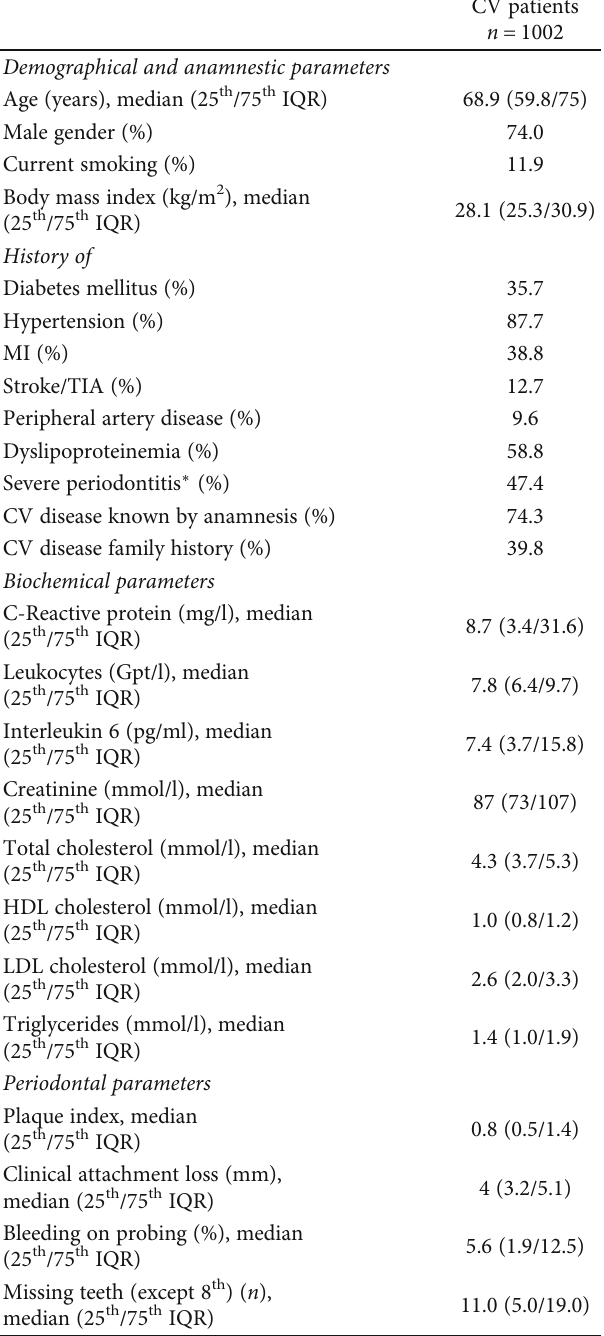
Table 2: Demographical and anamnestic parameters, previous history of diseases, biochemical parameters, and dental parameters of the CV patients.